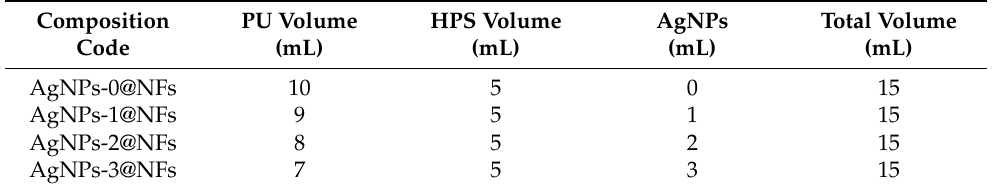
Lists the utilized volumes of polymers and AgNPs used for the preparation of electrospinning